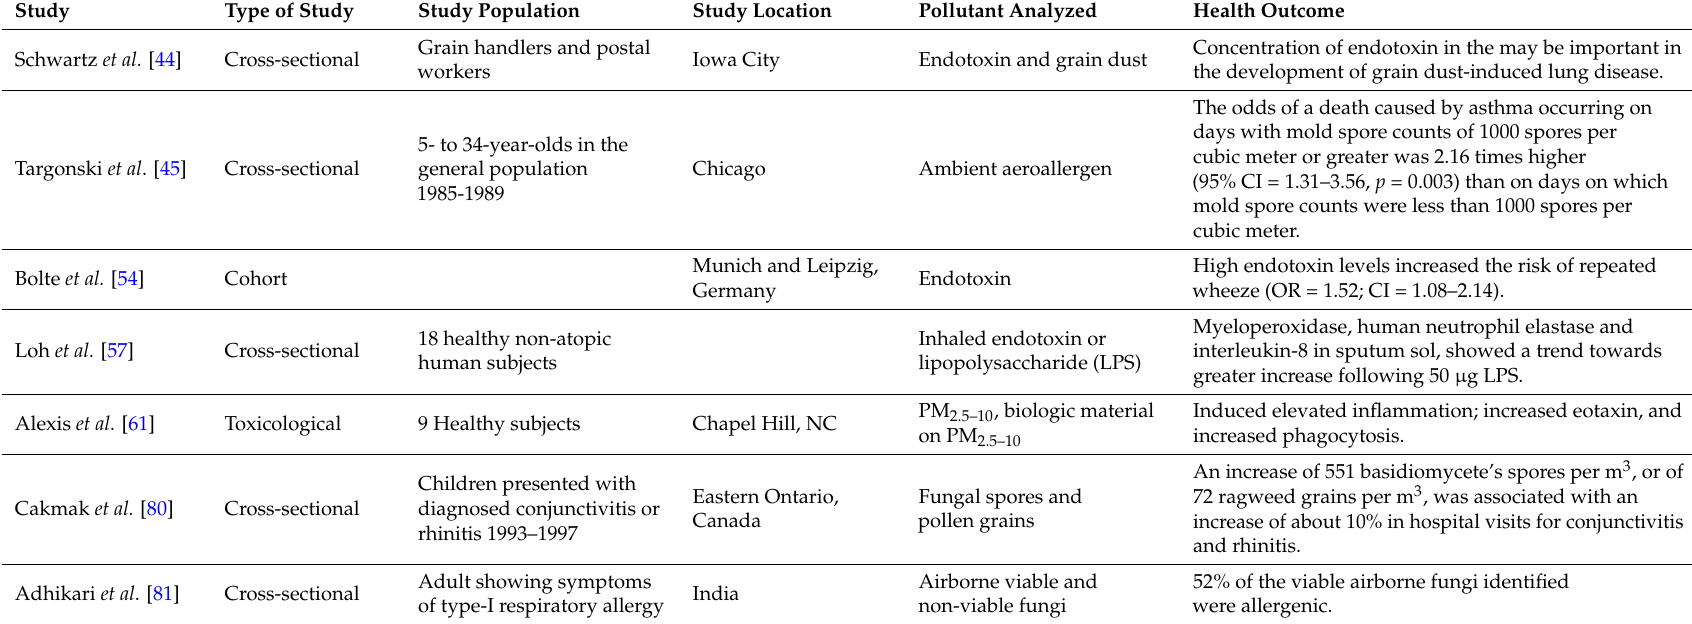
Table 1. Summary of epidemiological and toxicological studies on health effects of exposure to biological components of